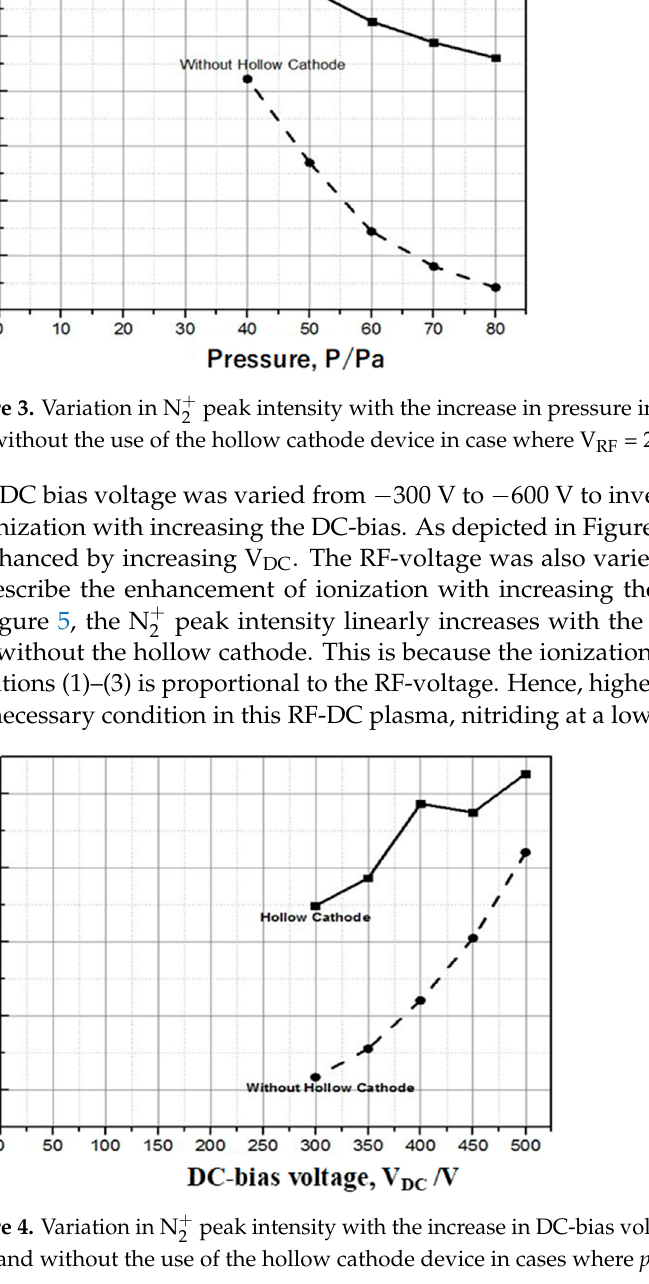
Figure 4. Variation in N + peak intensity with the increase in DC-bias voltage in the plasma diagnosis, with and without the use of the hollow cathode device in cases where p = 50 Pa and V RF = 250 V.